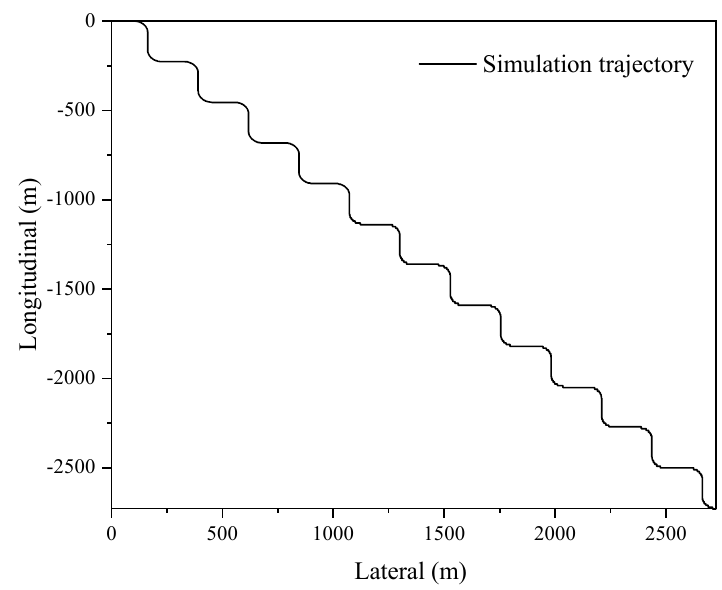
Figure 6. Serpentine shape motion trajectory.